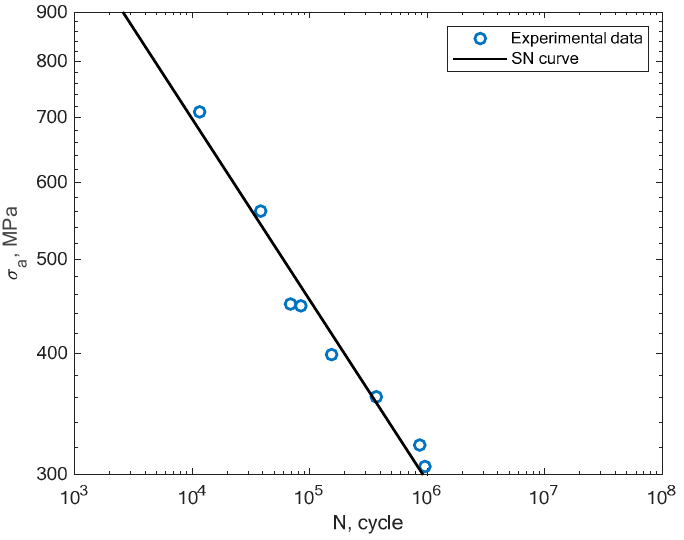
Figure 7. S–N curve for the experimental tension–compression fatigue test results of 1.2709 steel obtained by the authors under R = − 1.